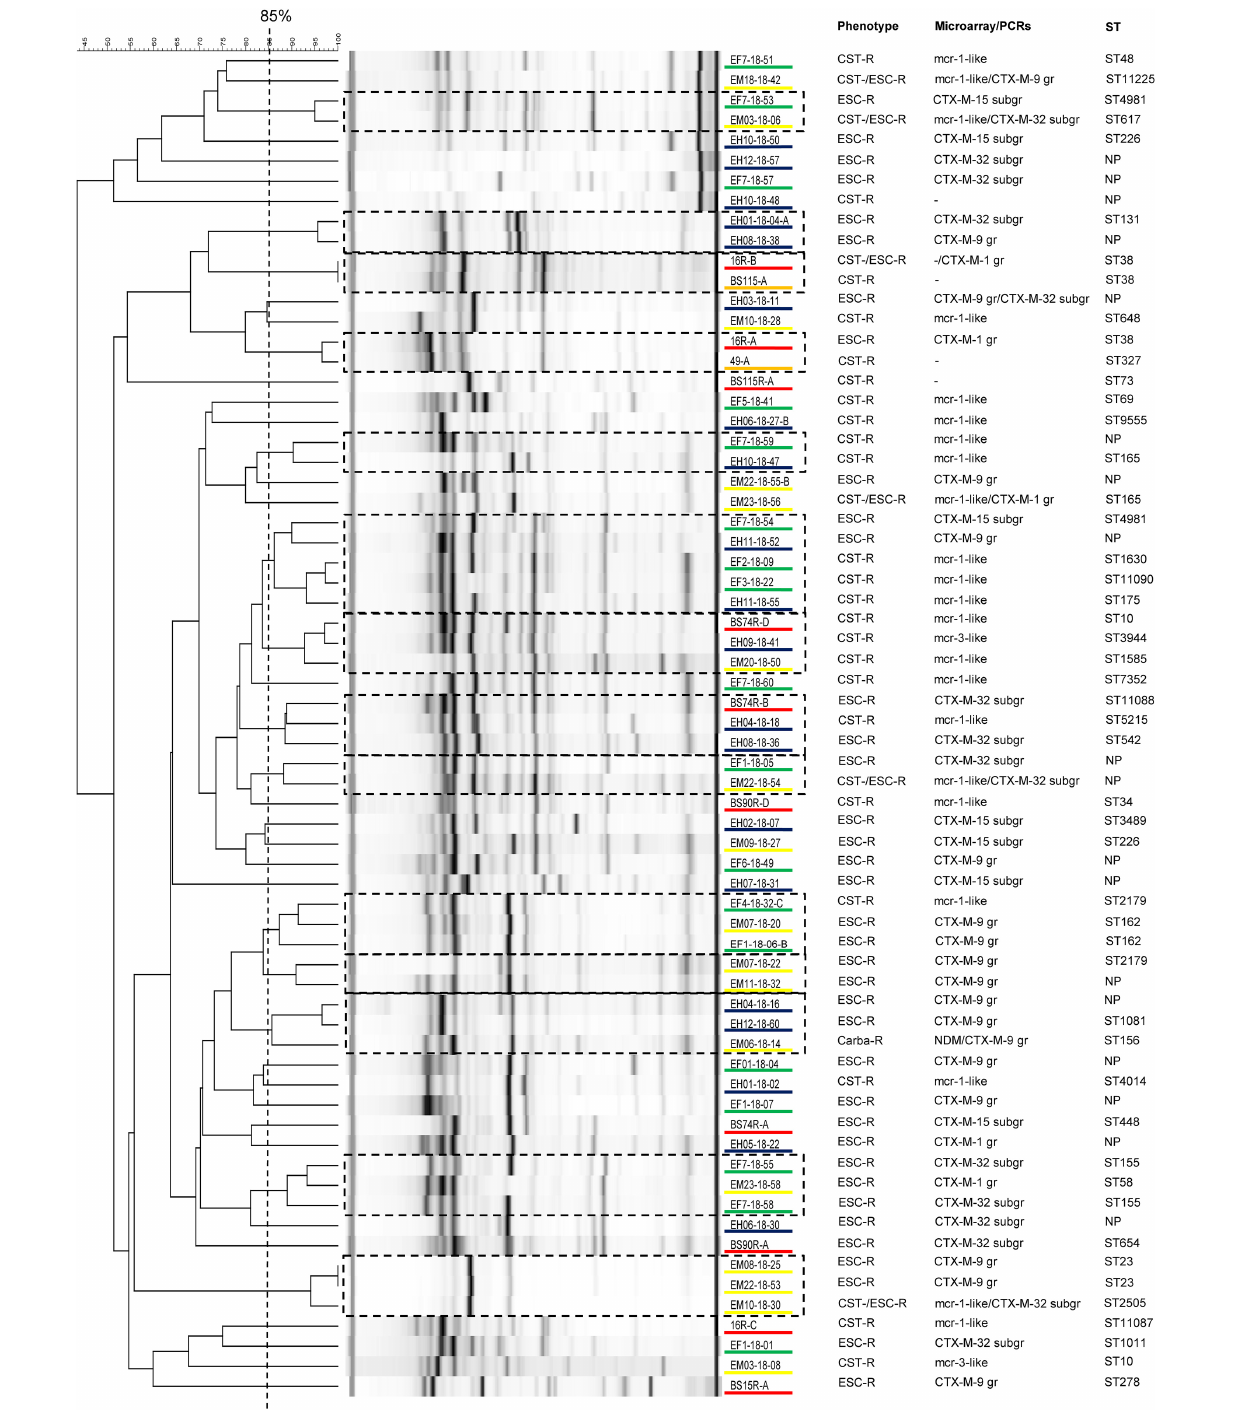
FIGURE 1 | Analysis of the rep-PCR results from 67 Escherichia coli ( Ec ) strains isolated from local people ( n = 20 out of 51 detected), poultry ( n = 18 out of 28 detected), chicken meat ( n = 17 out of 17 detected), Swiss residents after traveling to Laos ( n = 10 out of 10 detected), and Swiss residents before traveling ( n = 2 out of 3 detected). Strains showing an identity of ≥ 85% were considered to belong to the same clone. For each isolate, we show the phenotype, the main antimicrobial resistance genes (ARGs) detected by using microarray or PCRs, and the sequence type (ST). Isolates underlined in blue are from local people in Laos, in green from poultry, in yellow from chicken meat, in orange from Swiss residents before traveling, and in red from returning travelers. ESC-R, extended-spectrum cephalosporin-resistant; CST-R, colistin-resistant; Carba-R, carbapenem-resistant; NP, not performed (strains not typed with WGS); -, mcr and/or bla ESBL genes not detected; gr, group; subgr,